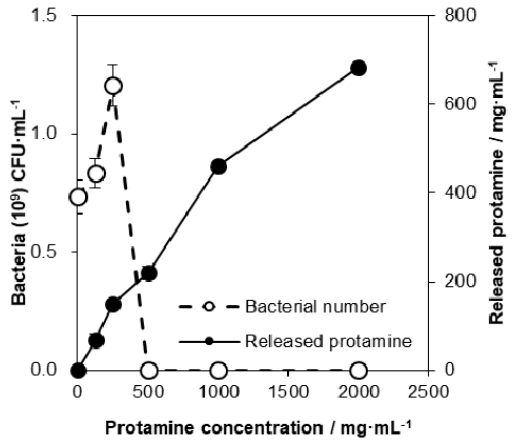
Figure 5. Relationship between released protamine and bacterial number. E. coli cells were cultured on various concentrations of protamine / HAp discs for 24 h. The released protamine into Luria-Broth (LB) medium was measured by the Bio-Rad protein assay. The number of bacteria in supernatants after 24 h culture was determined by measuring the optical density (OD) at 600 nm.